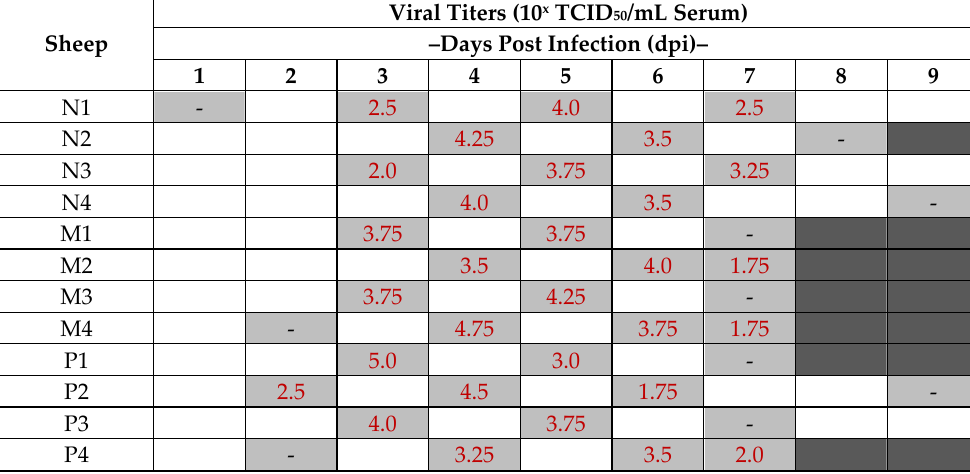
Table 2. Viral serum titers in sheep during the viremic state.